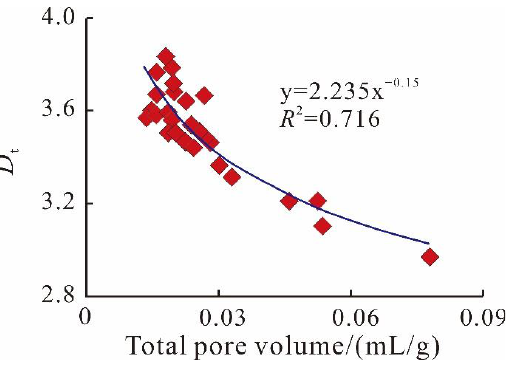
Figure 10. Relationship between total pore volume and diffusion fractal dimension ( D d ).